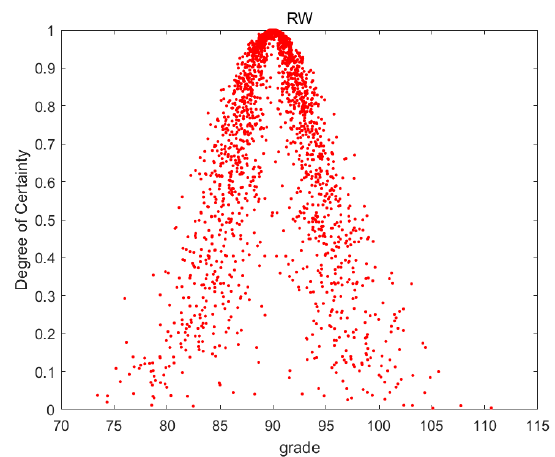
Figure 6. Cloud image of LG.